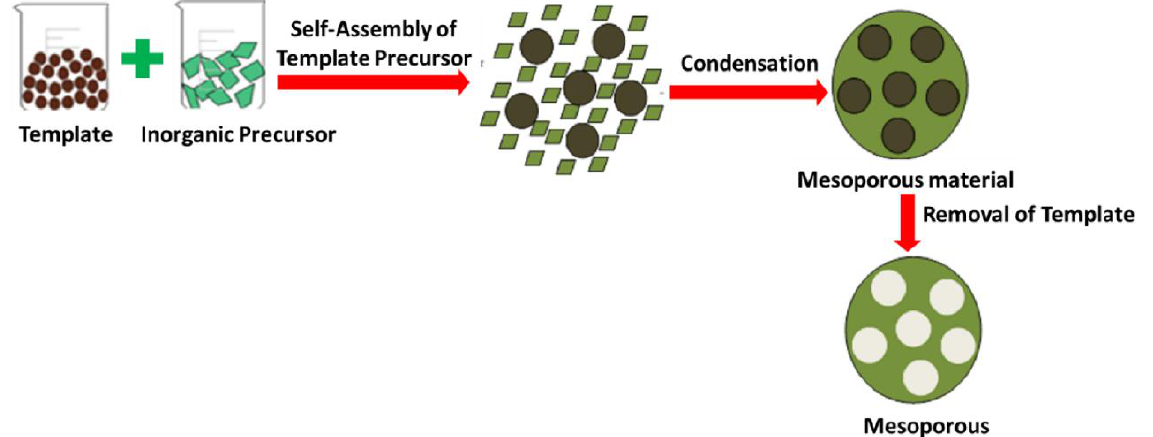
Figure 3. Synthetic procedure template-assisted for MOx nanostructures. Reprinted with permission from Ref. [56]. Copyright 2022 Elsevier.